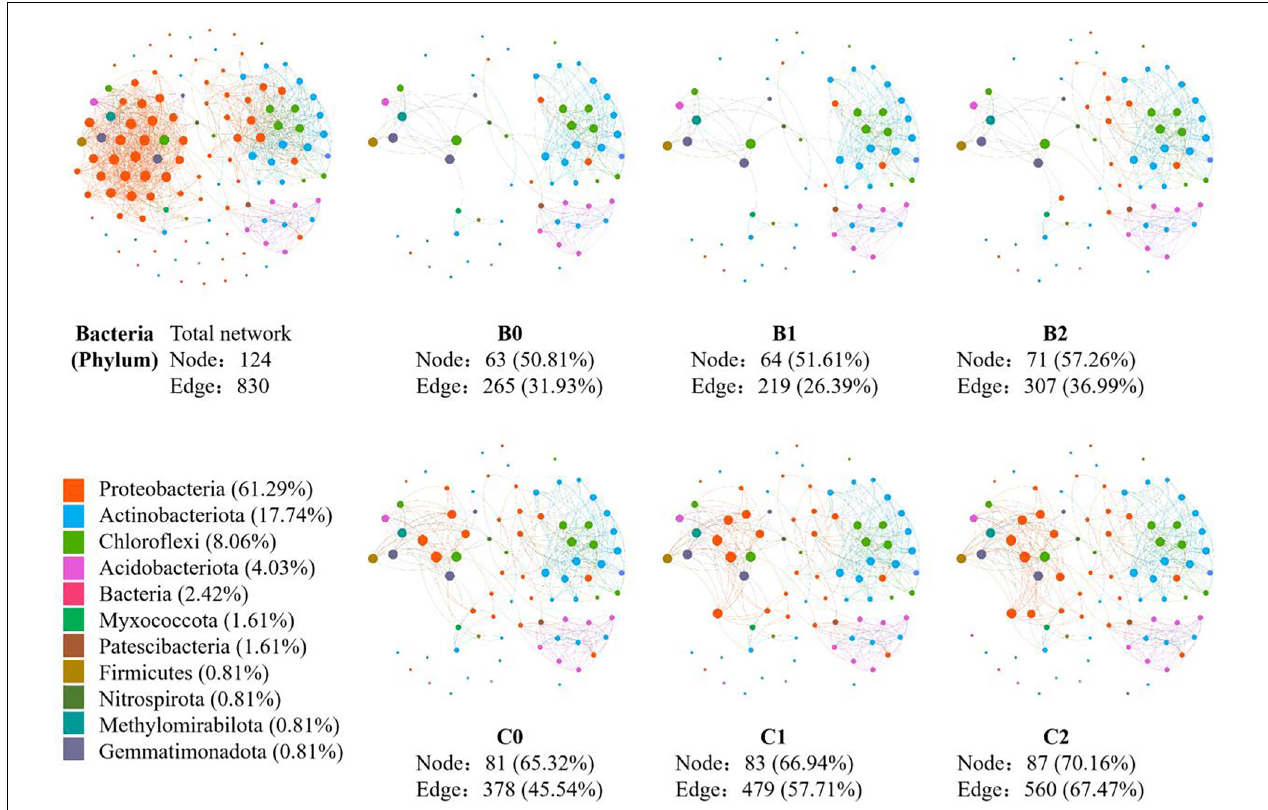
FIGURE 3 | The co-occurrence pattern of total bacterial community and each sub-network fallowing co-inoculation of Bradyrhizobium japonicum 5038 and Bacillus aryabhattai MB35-5 in black and cinnamon soil.